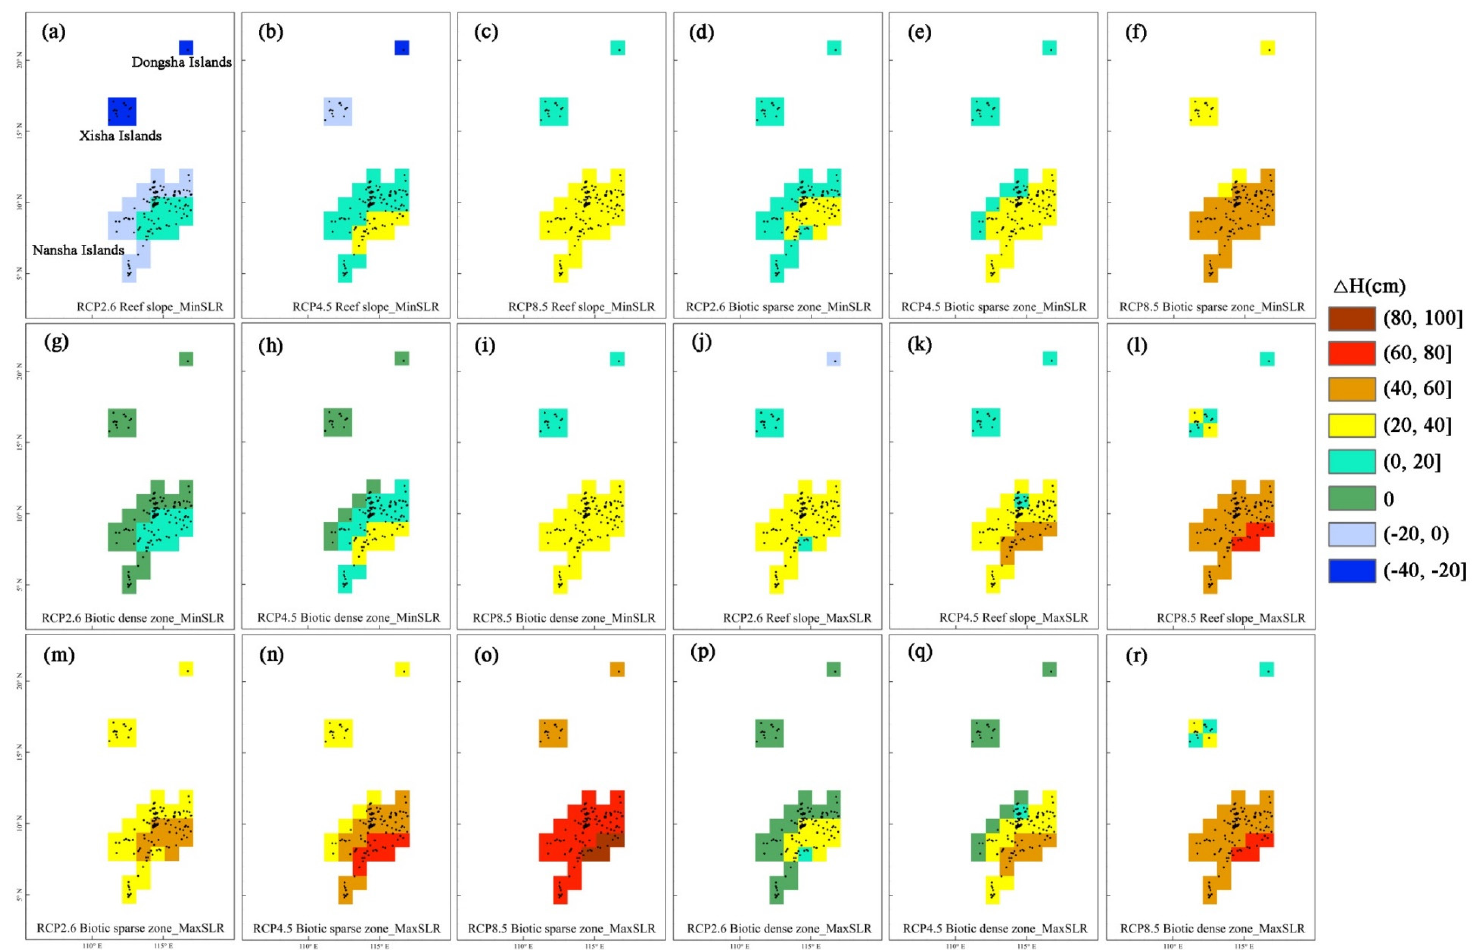
Figure 5. Projected bathymetry changes in geomorphic and reef flat ecological zones for atolls and table reefs above 2014 levels by 2100 in the South China Sea under global warming and minimum sea-level rise (minSLR) and maximum sea-level rise (maxSLR) under RCP2.6, RCP4.5 and RCP8.5. ( a – c , j – l ) are for reef slopes; ( d – f , m – o ) are for biotic sparse zones of reef flat; ( g – i , p – r ) are for biotic dense zones of reef flat.